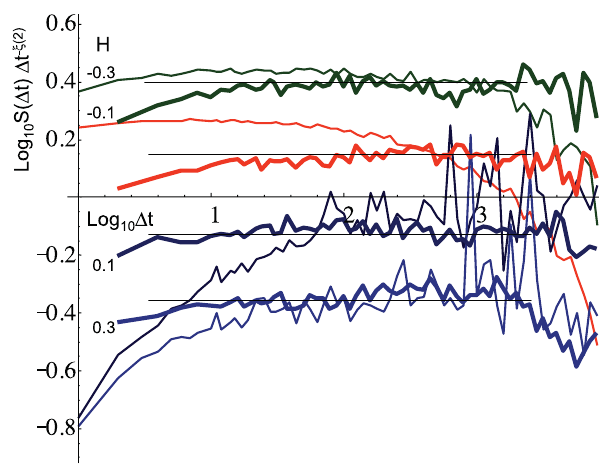
Fig. 8. This compares the compensated Haar structure function (thick), the difference structure function (thin, below the axis, for H = 3 / 10 (bottom) and 1 / 10 black, second up), and the tendency structure function (third from bottom, thin red, H = − 1 / 10), and top, thin green, H = − 3 / 10. It can be seen that the standard dif- ference structure function has poor scaling for nearly two orders of magnitude when H = 1 / 10, and one order of magnitude for H = 3 / 10 (see Fig. 6 for quantitative